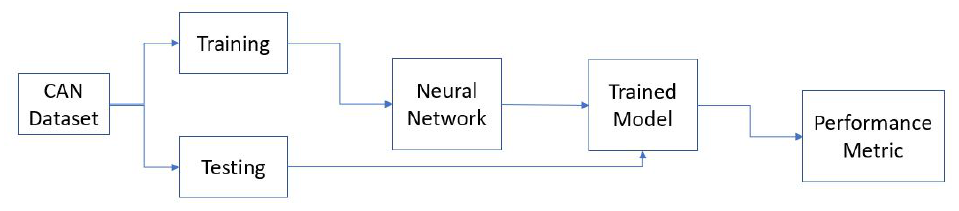
Figure 7. Modules of proposed IDS The flow process of the proposed solution for anomaly detection is shown in Figure 8.